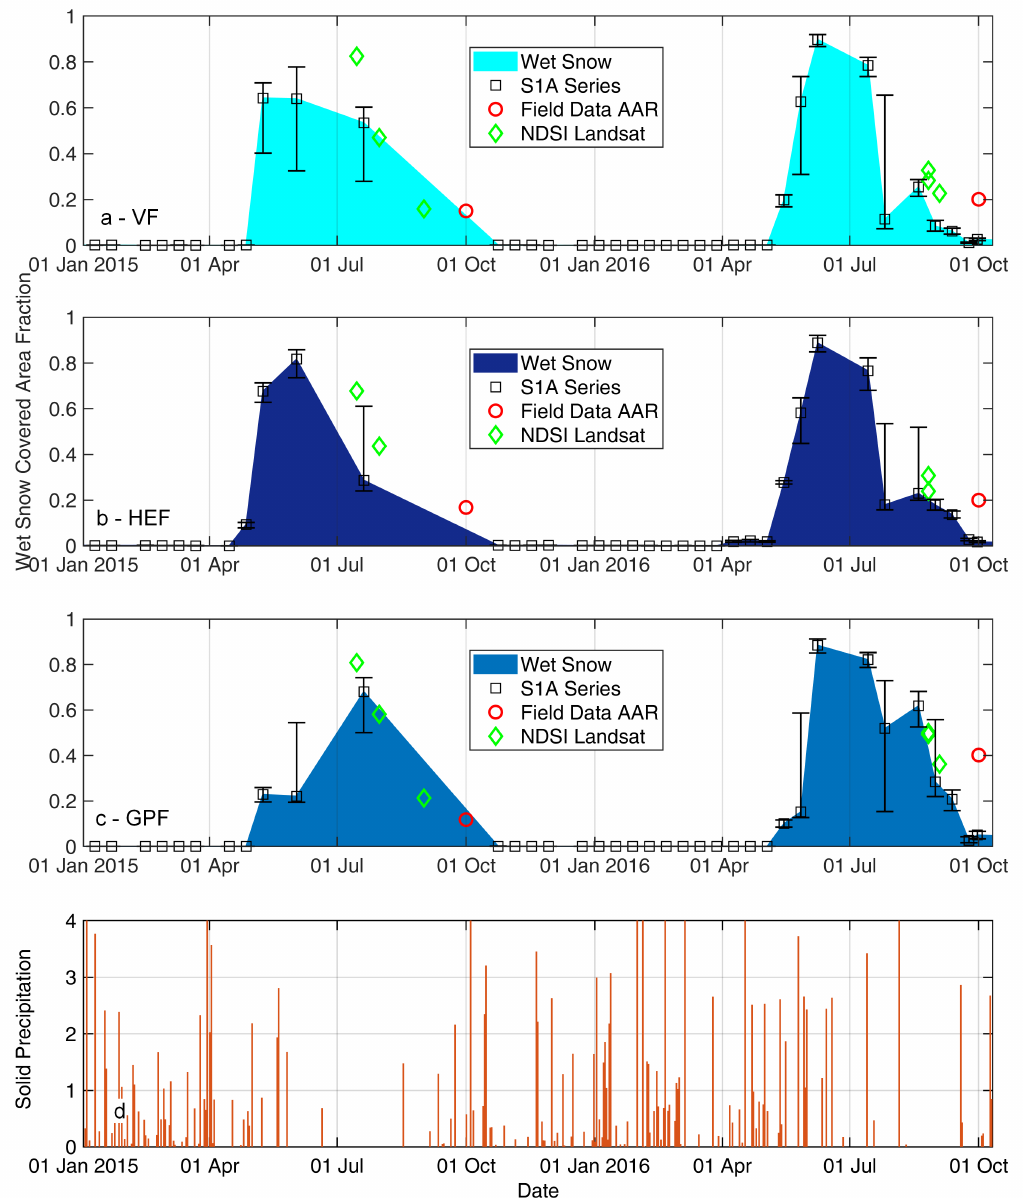
Figure 5. Wet snow covered area fraction for Sentinel-1 (S1) series per area of interest (AOI) Vernagtferner (VF) ( a ), Hintereisferner (HEF) ( b ), Gepatschferner (GPF) ( c ) and results for the new snow index ( d ) from January 2015 - October 2016. Black rectangles display S1 scenes with error bars for uncertainties in thresholds, red circles show field data determined accumulation area ratio (AAR) and green diamonds display results for the normalized difference snow index (NDSI) from Landsat images and snow classification results from Sentinel-2 data. Field data for the AOI GPF in ( c ) were only acquired for Kesselwandferner.